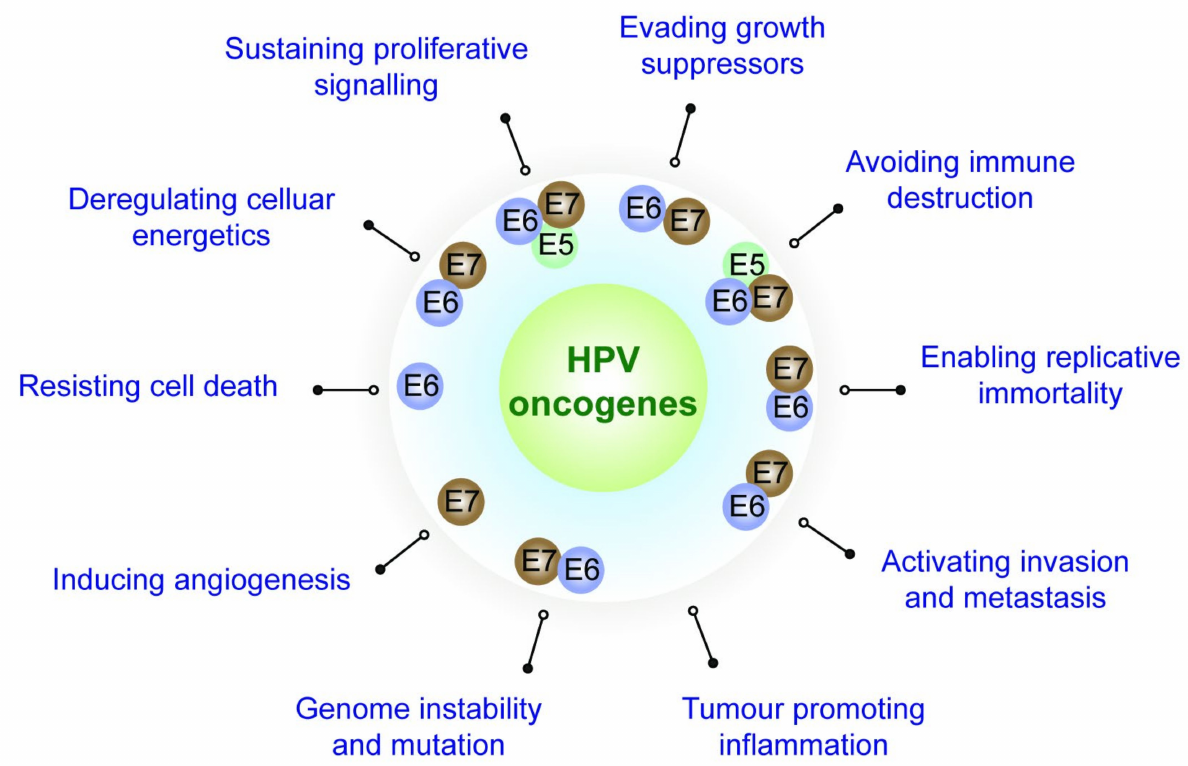
Figure 1. The hallmarks of cancer adapted from Hanahan and Weinberg 2016 [2]. A schematic illustrating eight distinct functional capabilities and two facilitators that are necessary conditions for the manifestation of malignant disease—cancer— and the expression of the HPV oncoproteins responsible for attaining these